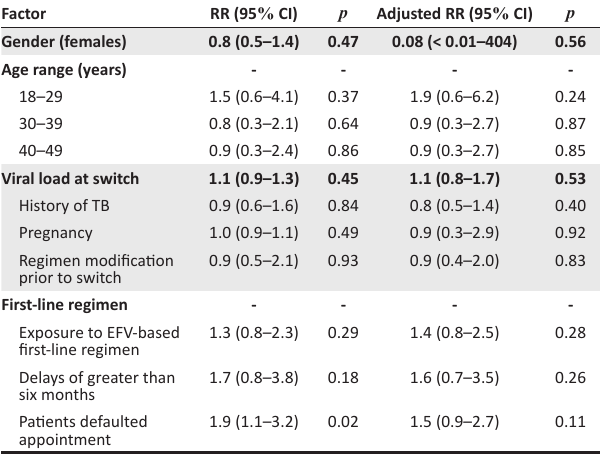
TABLE 3: Programmatic, patient-related and clinical variables associated with virological failure at an antiretroviral clinic in eThekwini Health District, 2011 to